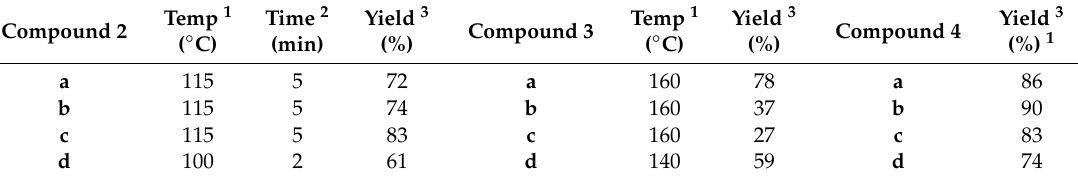
Table 1. Experimental conditions for the synthesis of compounds 2 , 3 and 4